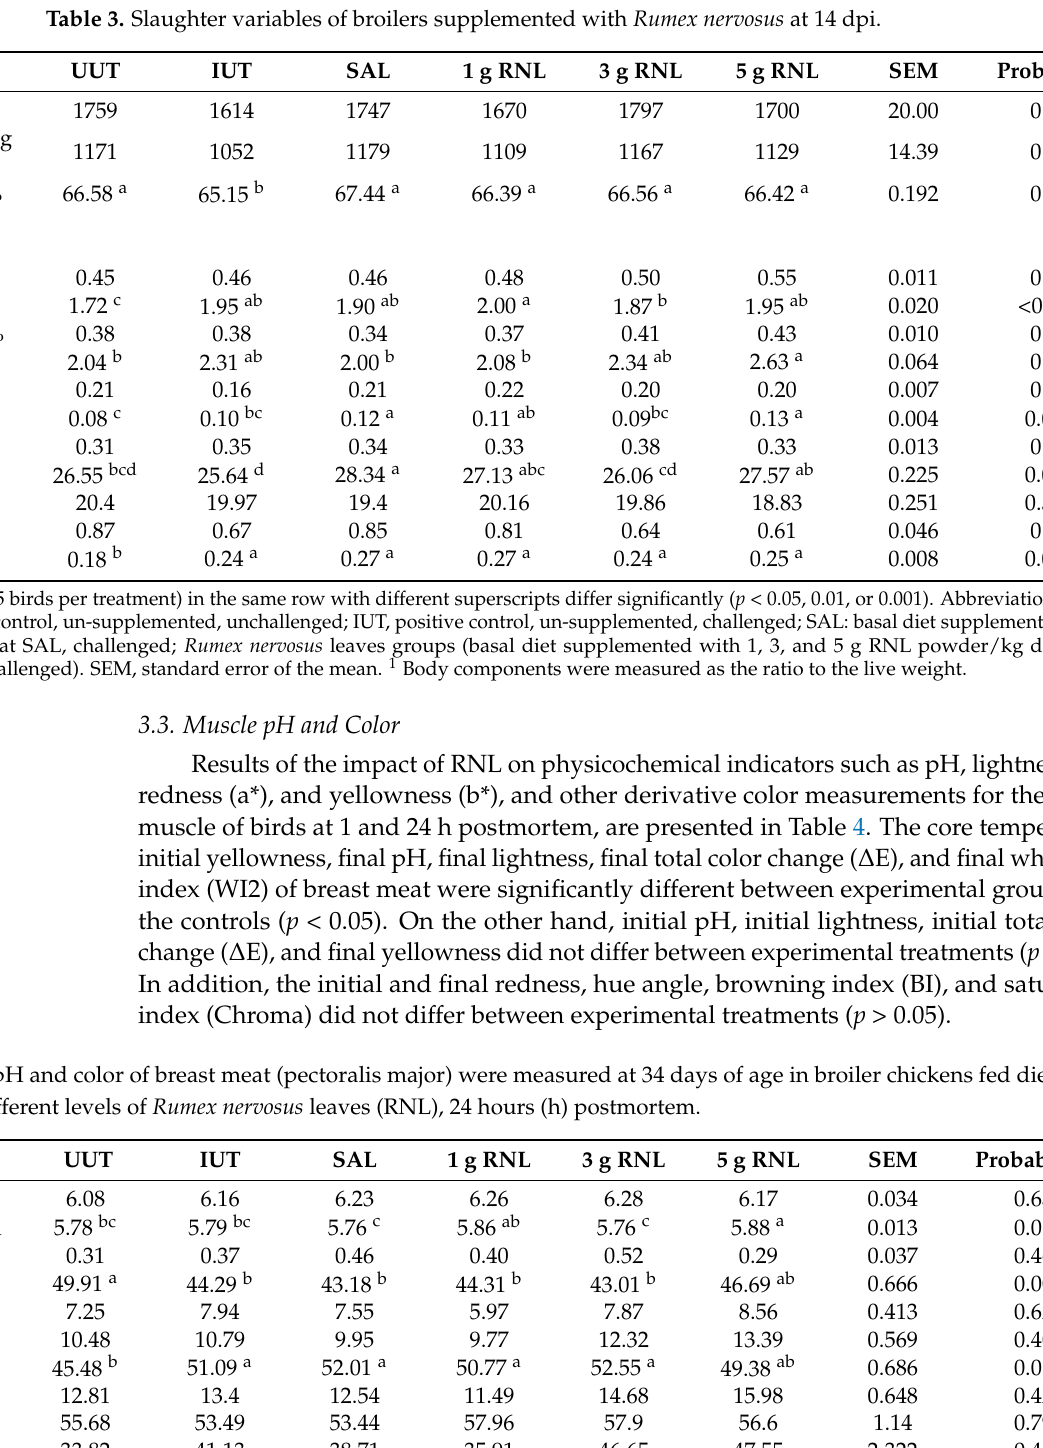
Table 3. Slaughter variables of broilers supplemented with Rumex nervosus at 14 dpi.